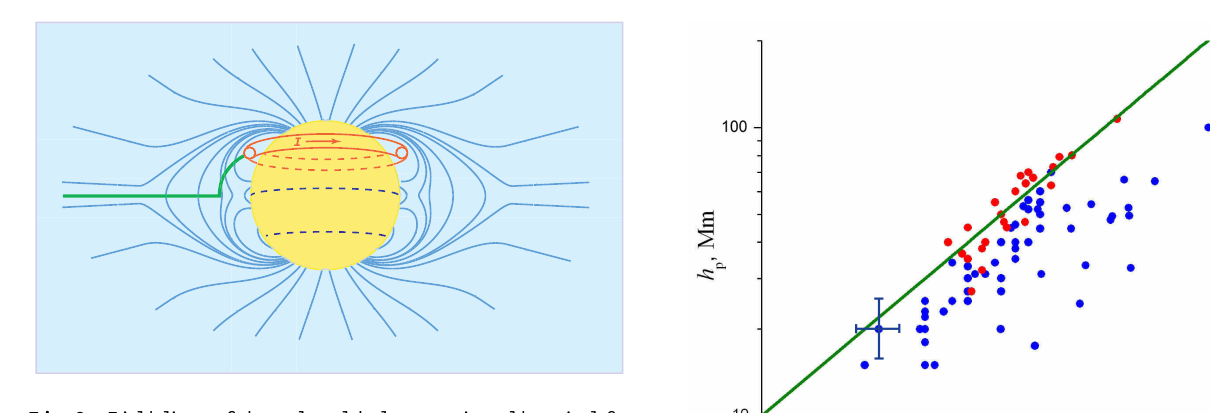
versus the critical height of stable filament equilibrium h c . The blue circles correspond to the filaments which safely passed the west limb. The red circles correspond to the filaments which disappeared from the disk. The straight green line corresponding to an equality of these quantities is the stability